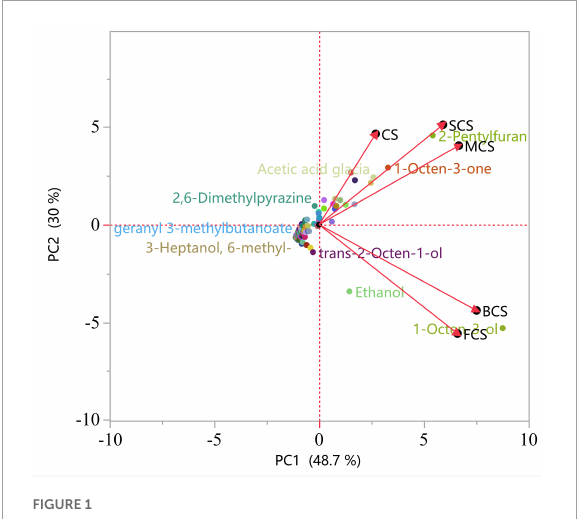
FIGURE1 Principal component analysis (PCA) scores and load plots of volatile flavor compounds under different cooking methods. CS, C. squamulosa ; BCS, boiling-cooked C. squamulosa ; SCS, steaming-cooked C. squamulosa ; MCS, microwaving-cooked C. squamulosa ; FCS, frying-cooked C. squamulosa